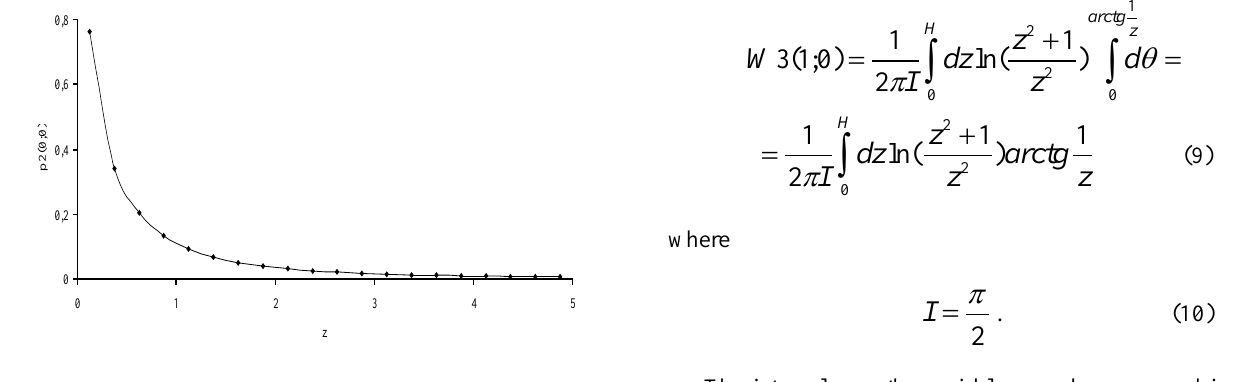
Fig. 5. Density of the probability distribution of collisions of atoms with the system wall. H = 5.